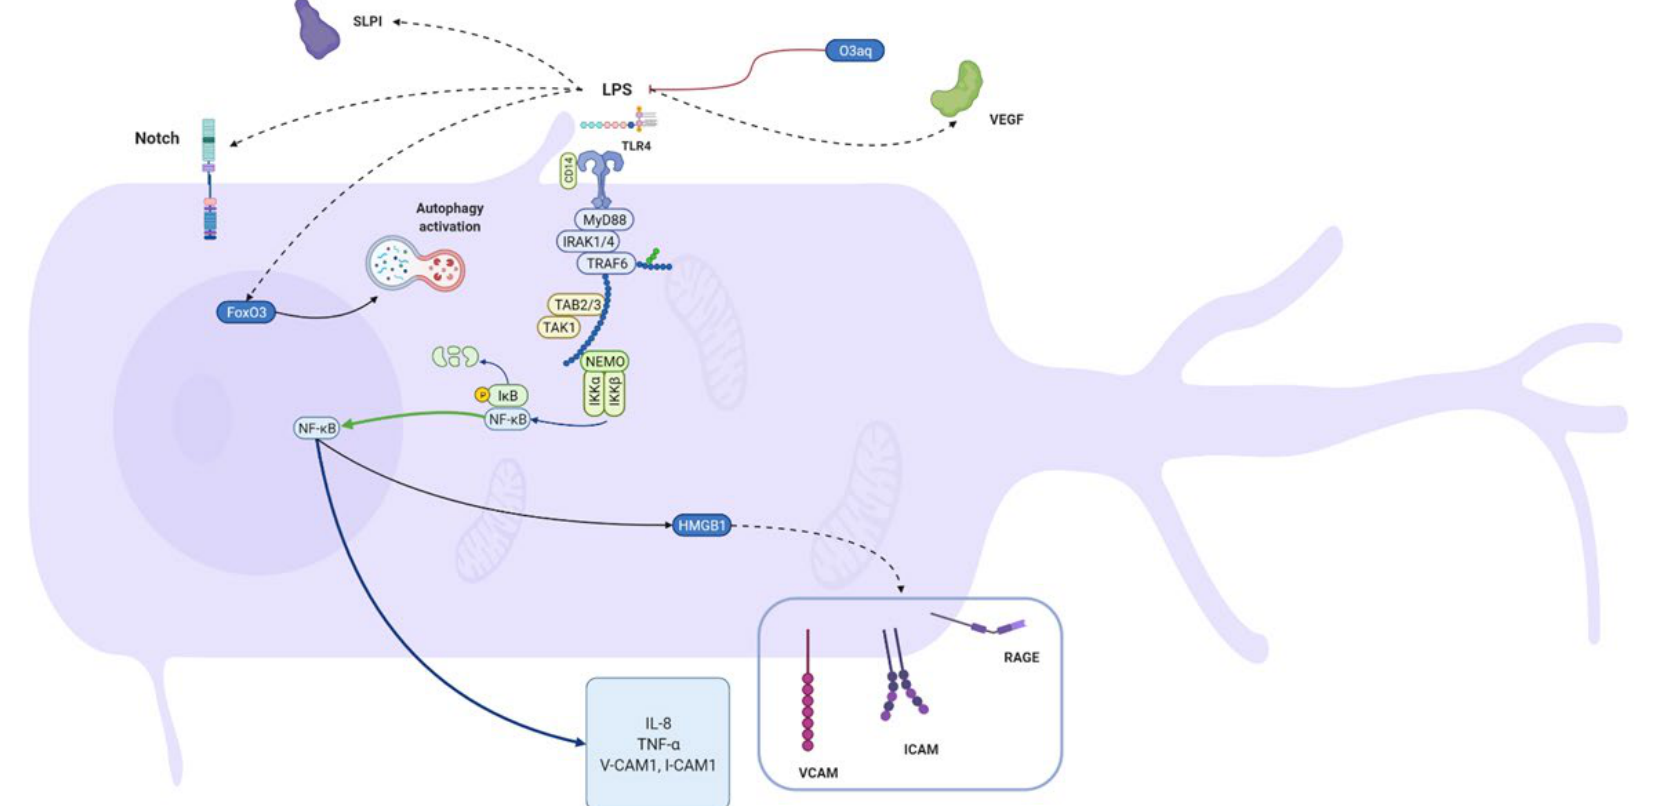
Figure 2. Molecular effects exerted by lipopolysaccharides on odontoblasts. Figure summarizes results from studies conducted on hDPCs, regardless of LPS origin. In odontoblasts a main role in LPS stimulation is played by the TLR/MyD88/NF- κ B pathway. This stimulation results in expression of IL-8, TNF- α and adhesion molecules. A variety of different pathways and particles activated in LPS-treated cells are presented both in deep blue brackets and by protein images with their names. Black arrows represent positive stimulation, dashed arrows show indirect activation, red ones—inhibition, green—translocation to another cell compartment. Created with BioRender.com 7 December